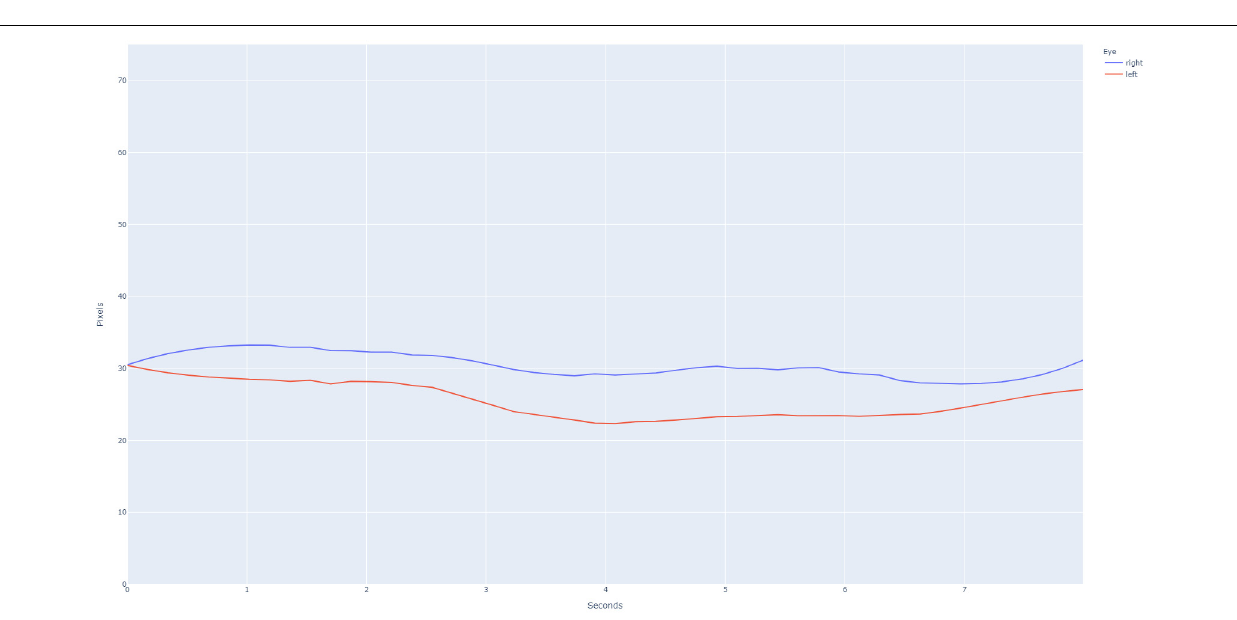
PLR, such as constriction velocity and amplitude (Ong et